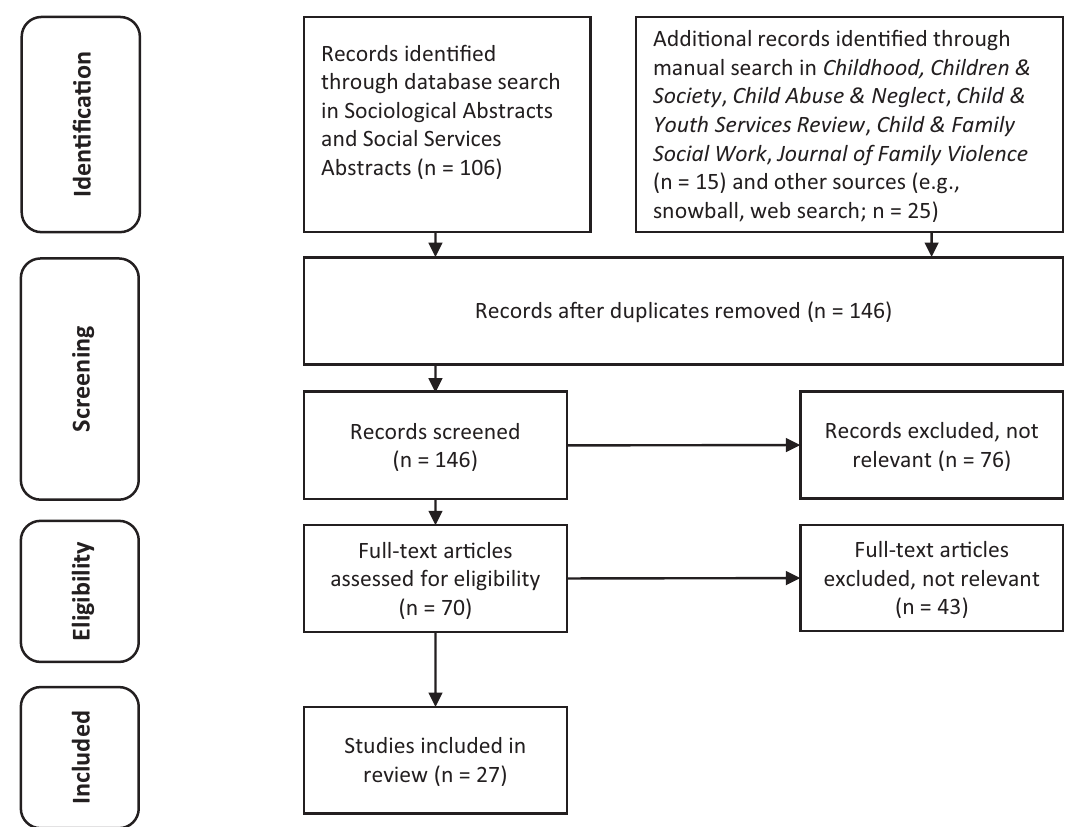
Figure 1. PRISMA flow